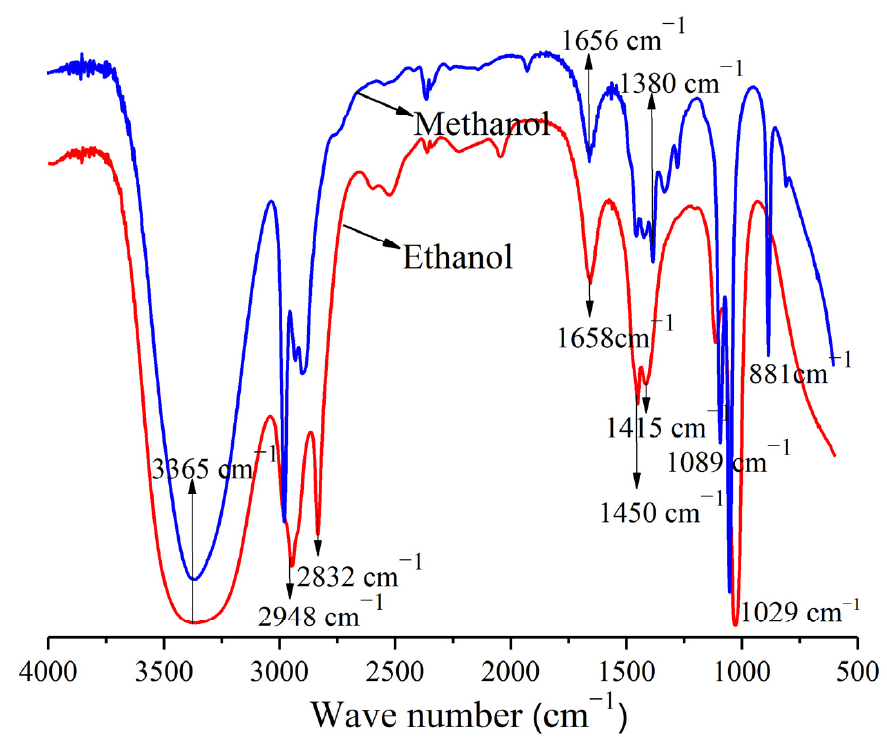
Figure 1. Fourier transform-infrared spectroscopic spectra of the ethanol and methanol samples of A. Bunge leaves.